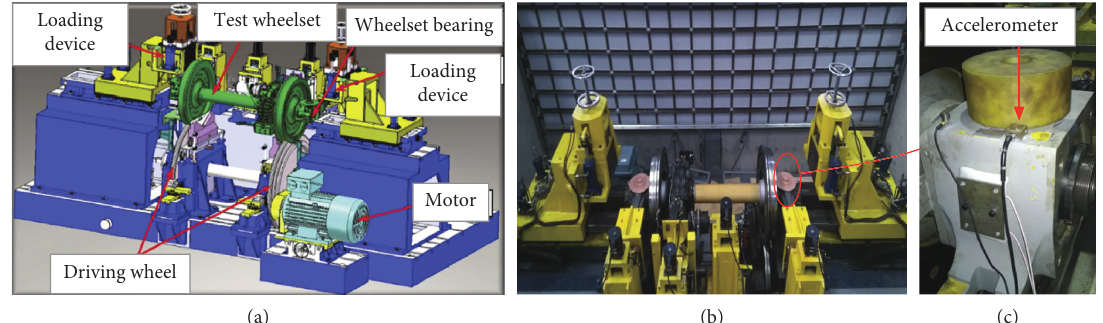
Figure 17: (a) Schematic sketch of the wheelset bearing test bench; (b) photographs of test bench; and (c) installation position of acceleration sensor.